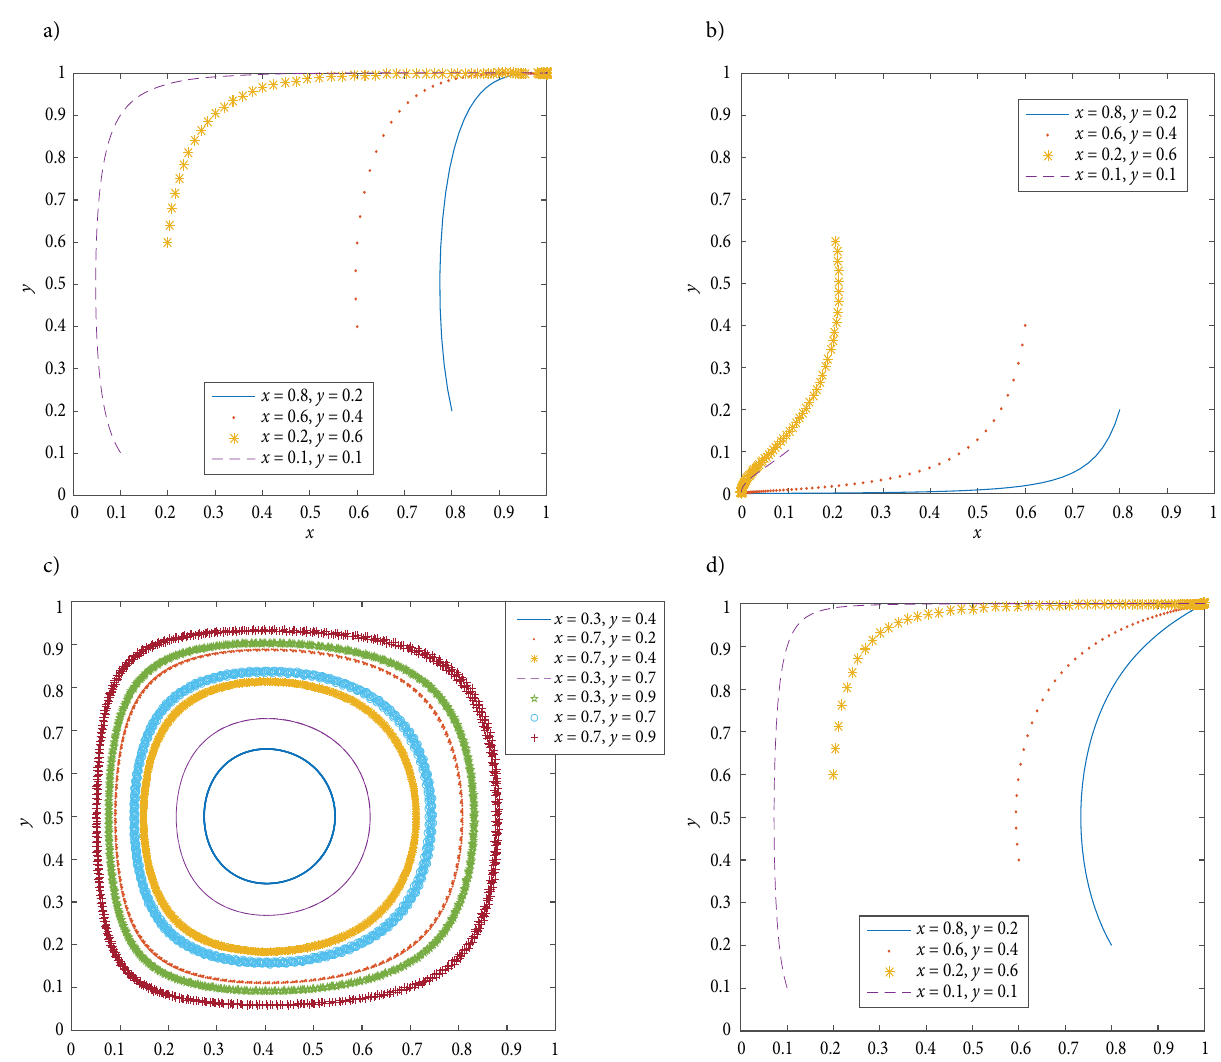
Figure 4. The evolutionary route based on Section 4.1, Scenario 1…3 of Section